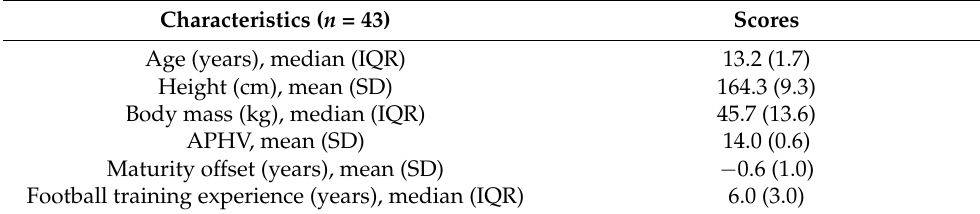
Table 1. Anthropometric characteristics and football experience of